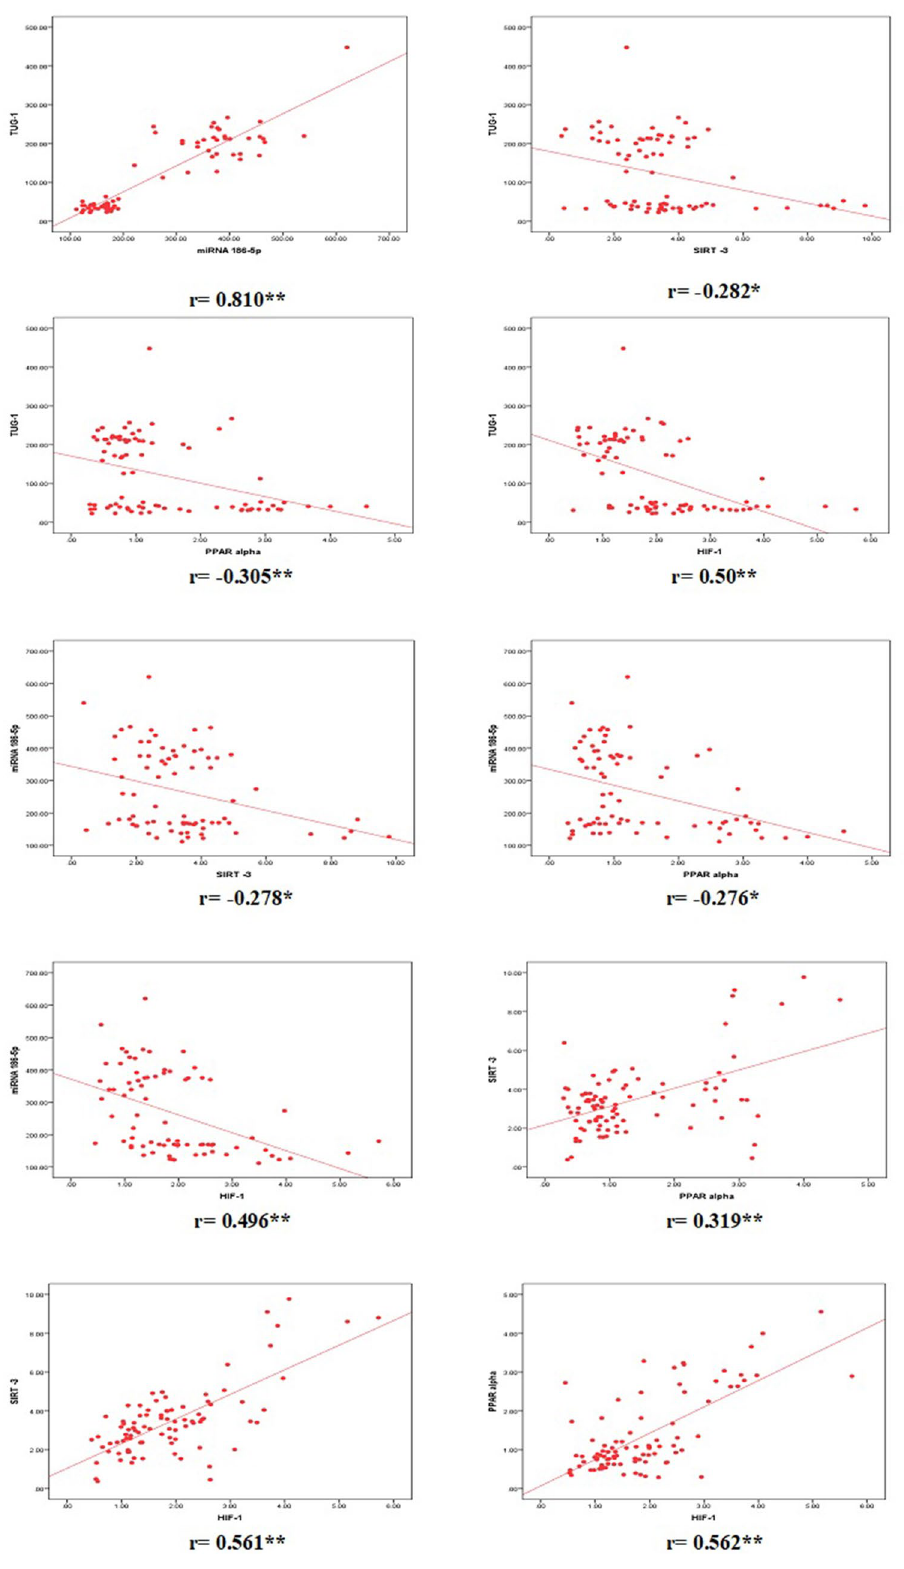
Figure 4. Correlations between TUG‑1, miRNA 186‑5, SIRT3, PPAR‑1α and HIF‑1α. In this figure, Spearman correlation coefficients were used to assess the correlation between two quantitative parameters in the same group. Regarding TUG‑1, it showed significant positive correlation with miR‑186 and significant negative correlation with SIRT‑3, PPAR‑1 α and HIF‑1α. On the other hand, miR‑186 showed significant negative correlation with SIRT‑3, PPAR‑1 α and HIF‑1α. Moreover, SIRT‑3 showed significant positive correlation with PPAR‑1 α and HIF‑1α. Last but not least, PPAR‑1 α showed significant positive correlation with HIF‑1α. R values (correlation coefficients) are shown below each